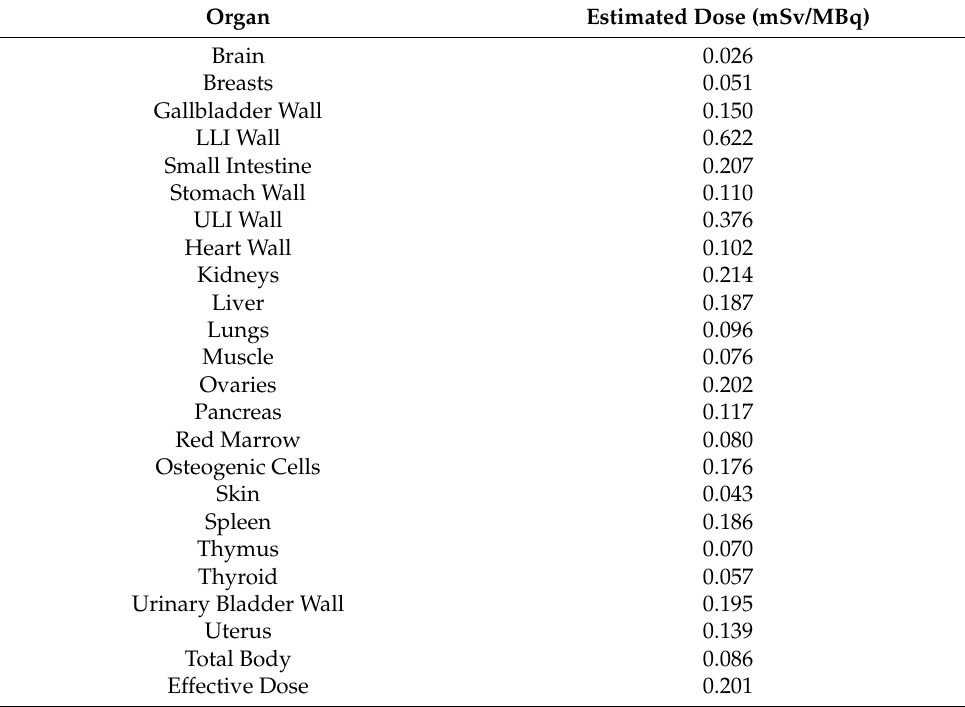
Table 4. Calculated organ radiation-dose estimates of 111 In-DOTA-EB-cRGDfK for humans.